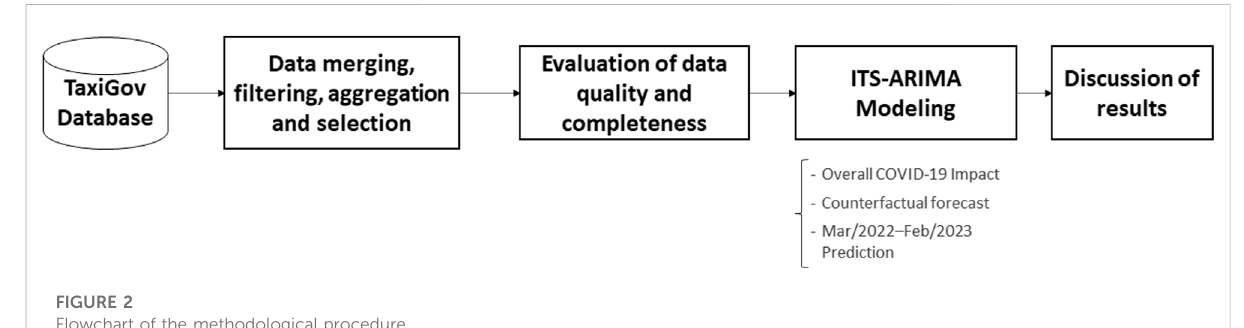
FIGURE 2 Flowchart of the methodological